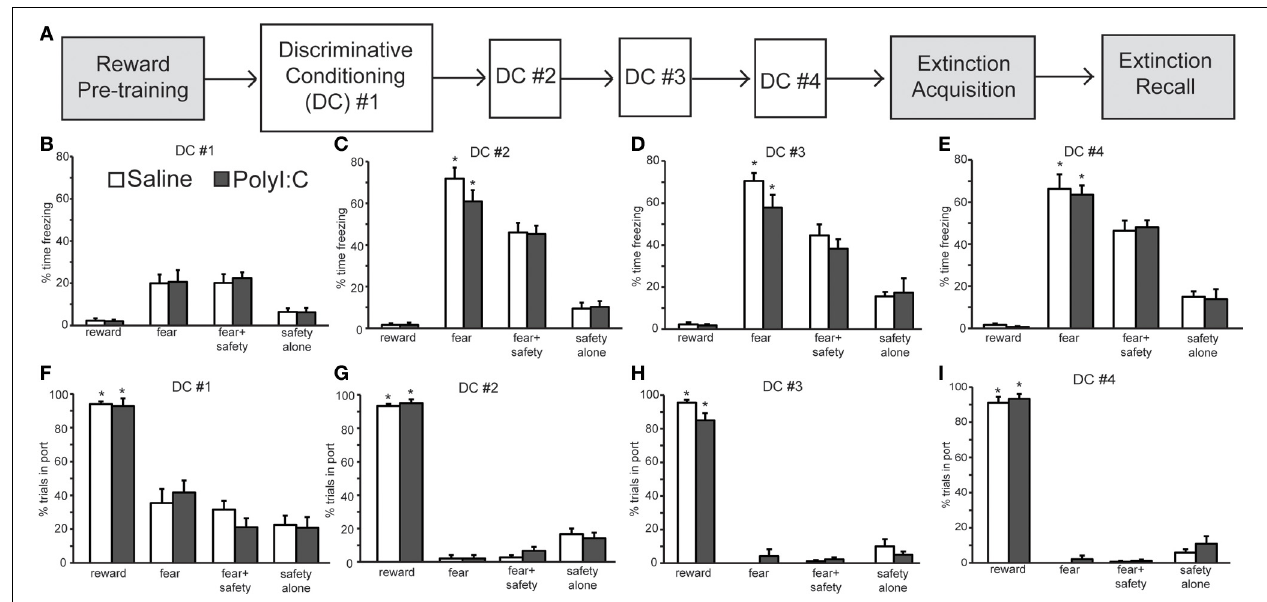
FIGURE 3 | Normal acquisition and performance of a discriminative conditioning task by both polyI:C- ( n = 12 from 11 dams) and saline-treated offspring ( n = 12 from 10 dams). (A) Schematic of experimental design. Rats were pre-trained on the reward cue-reward pellet association followed by 4 Discriminative Conditioning (DC) sessions in which the reward cue ( + reward pellet), fear cue ( + footshock), fear + safety cues (no footshock) and safety cue (no footshock) were presented. During Extinction Acquisition all rats received unreinforced presentations of the fear and reward cues. Extinction Recall occurred the